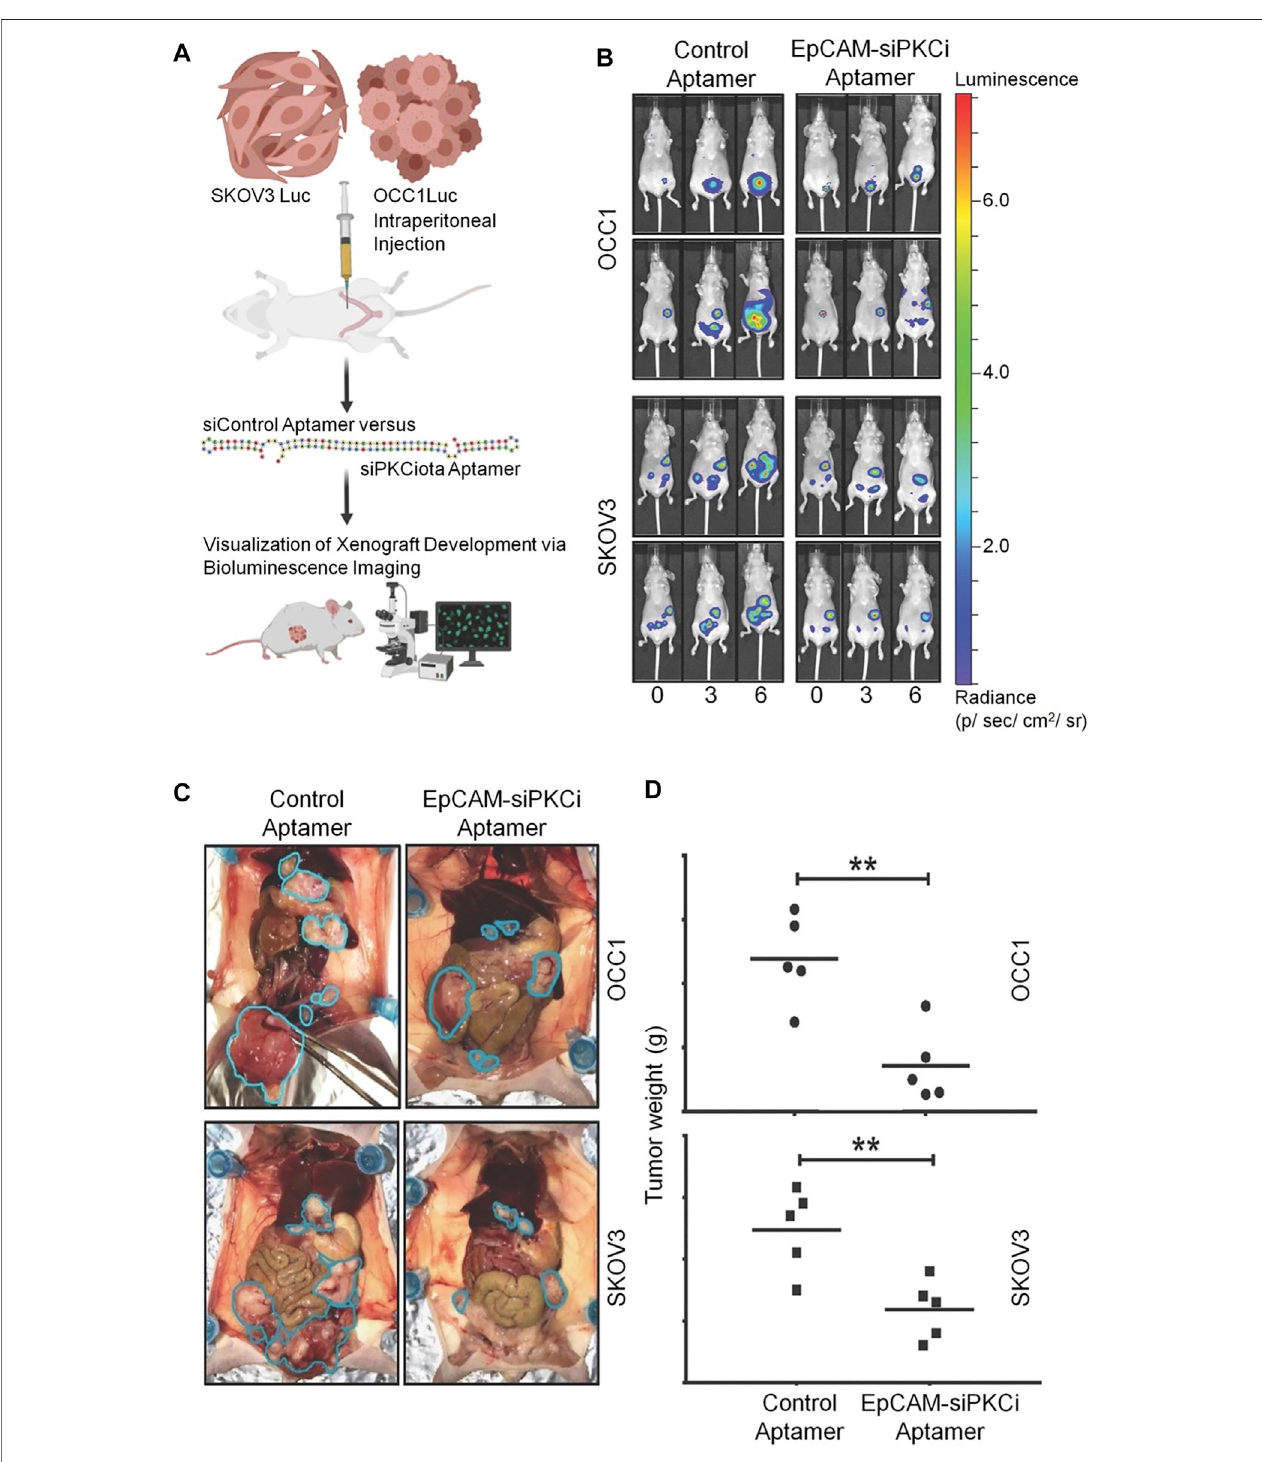
FIGURE 7 | EpCAM-siPKC ι aptamer therapy for ovarian cancer. (A) The experimental process of EpCAM-siPKC ι aptamer treatment. (B) Therapeutic effect of EpCAM-siPKC ι aptamer. (C) Anatomical pictures of mice after 7 weeks of treatment. (D) Tumor implants were collected and weighed.